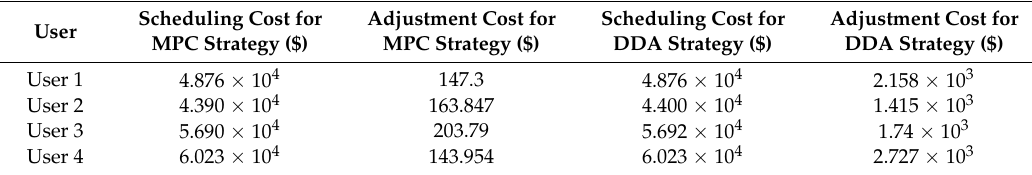
Table 6. Operation costs for each user with different strategies.